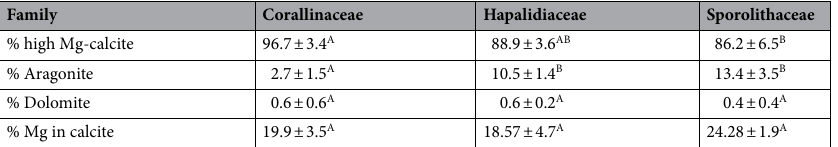
Table 2. Mineralogy (mean ± standard deviation) of coralline algae families Corallinaceae, Hapalidiaceae and Sporolithaceae. Different letters are used to indicate statistically differences (p < 0.05) of percentage of CaCO 3 polymorphs obtained through post-hoc Dunn’s test after the Kruskal–Wallis